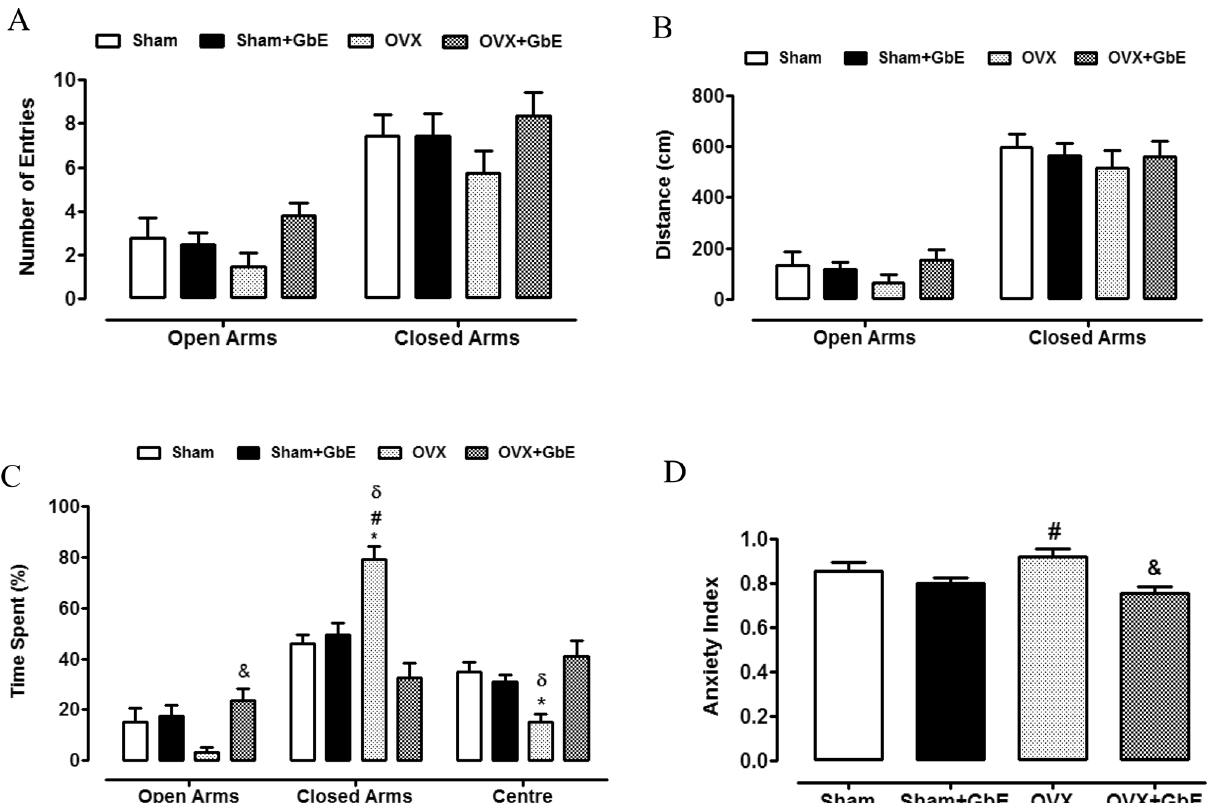
(n = 10–11), OVX (n = 10–11) and OVX + GbE rats (n = 9–11). *p ≤ 0.05 vs. Sham; # p ≤ 0.05 vs. Sham + GbE; & p ≤ 0.05 vs. OVX; δ p ≤ 0.05 vs. OVX +